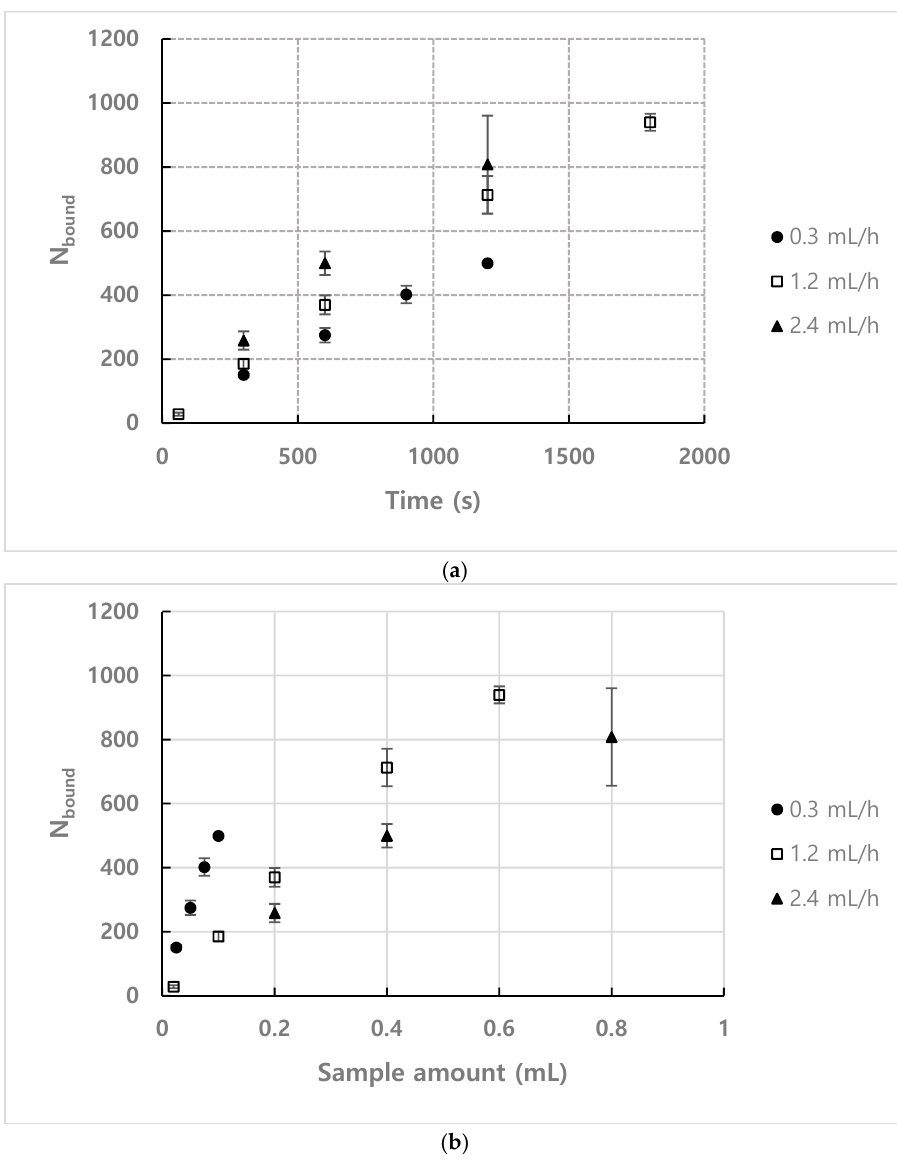
Figure 8. Number of bound particles depending on flow rate for ( a ) n = 1.93 × 10 14 m − 3 , observation position = 35 mm ( b ) n = 1.93 × 10 14 m − 3 , observation position = 35 mm.